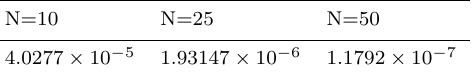
Table 3. Integrals of the squared residual errors for Lane-Emden equation of the second kind with m=10 iterations and various values for N . N=10 N=25 N=50 4 . 0277 × 10 − 5 1 . 93147 × 10 − 6 1 . 1792 × 10 −